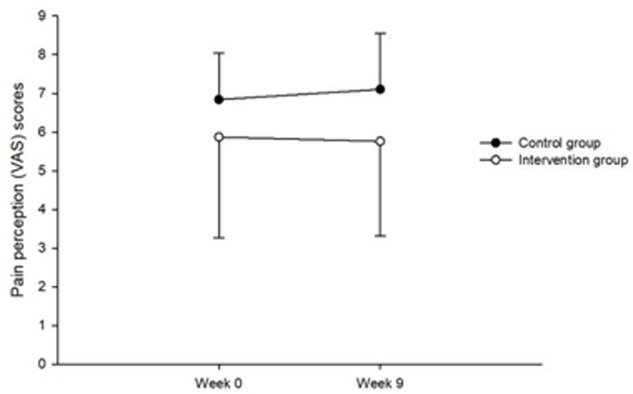
Showing the Time × Group interaction for pain perception.